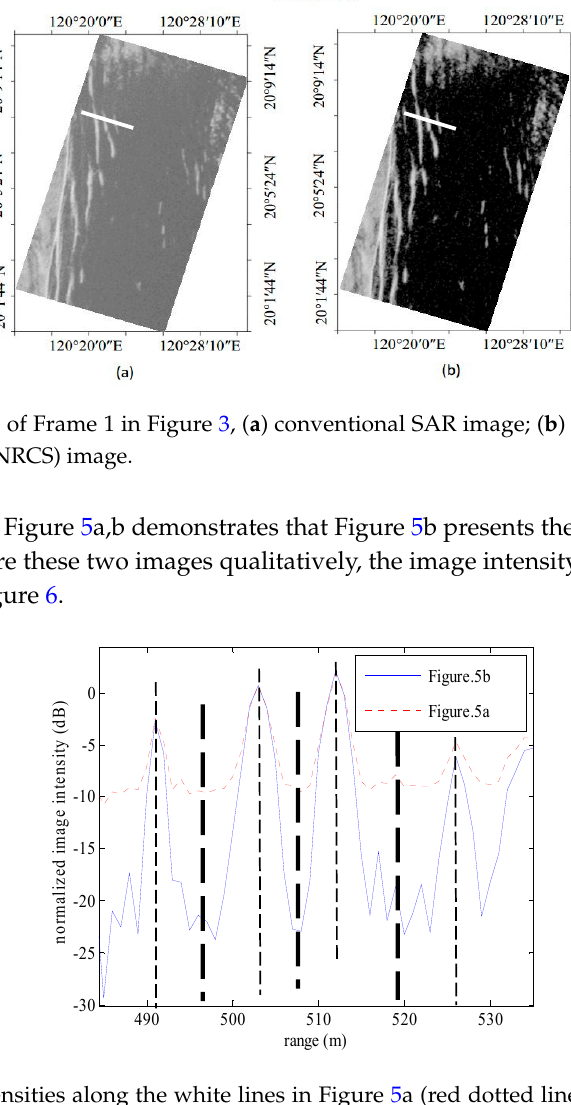
Figure 6. Image intensities along the white lines in Figure 5a (red dotted line) and Figure 5b (blue solid line).